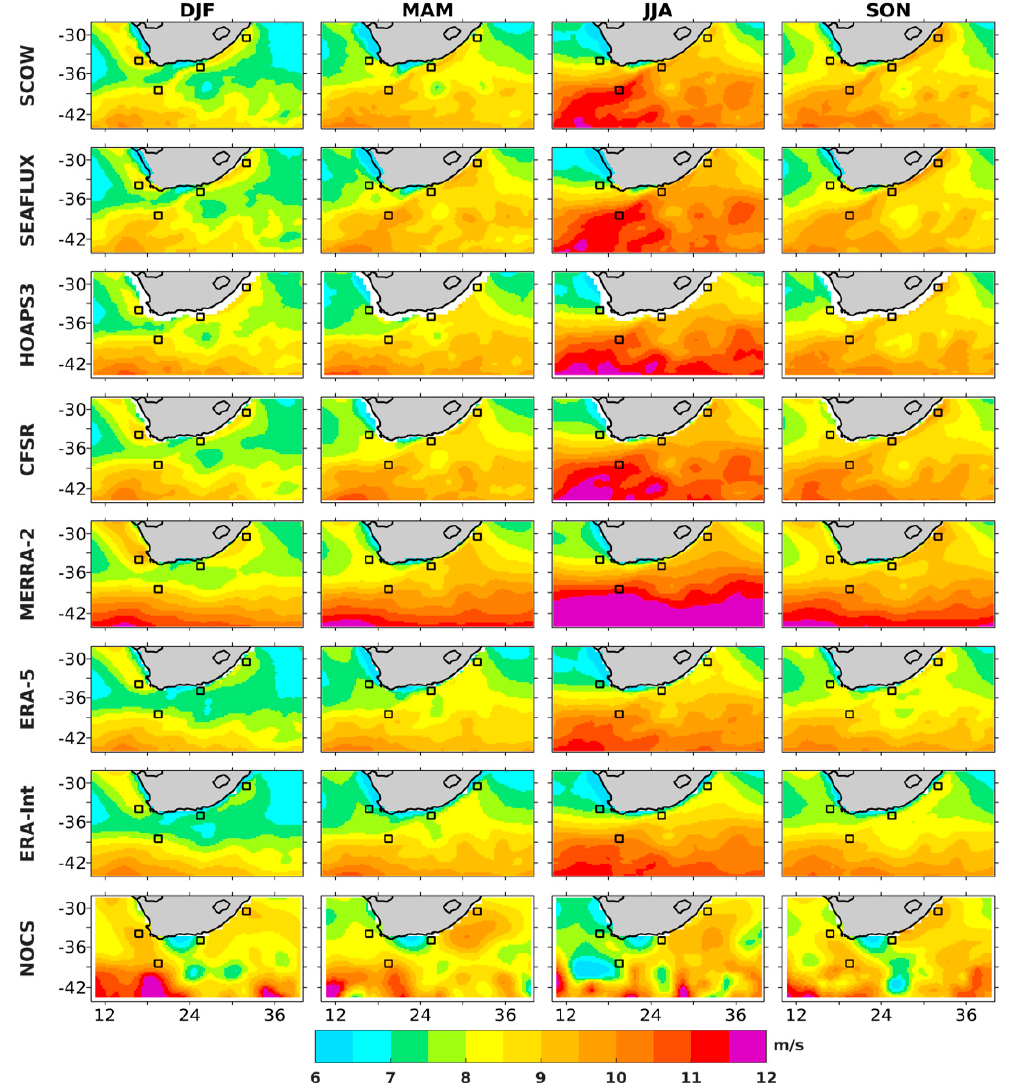
Figure 8. Seasonal average of surface wind speed (m / s) of SCOW, SEAFLUX, HOAPS3, CFSR, MERRA-2, ERA-Interim and NOCS. From left to right austral summer (DJF), austral autumn (MAM), austral winter (JJA) and austral spring (SON). Black squares represent the four locations taken for the study. SCOW wind is the reference for the wind speed. Products have been interpolated on the grid of SCOW (0.25° × 0.25°).